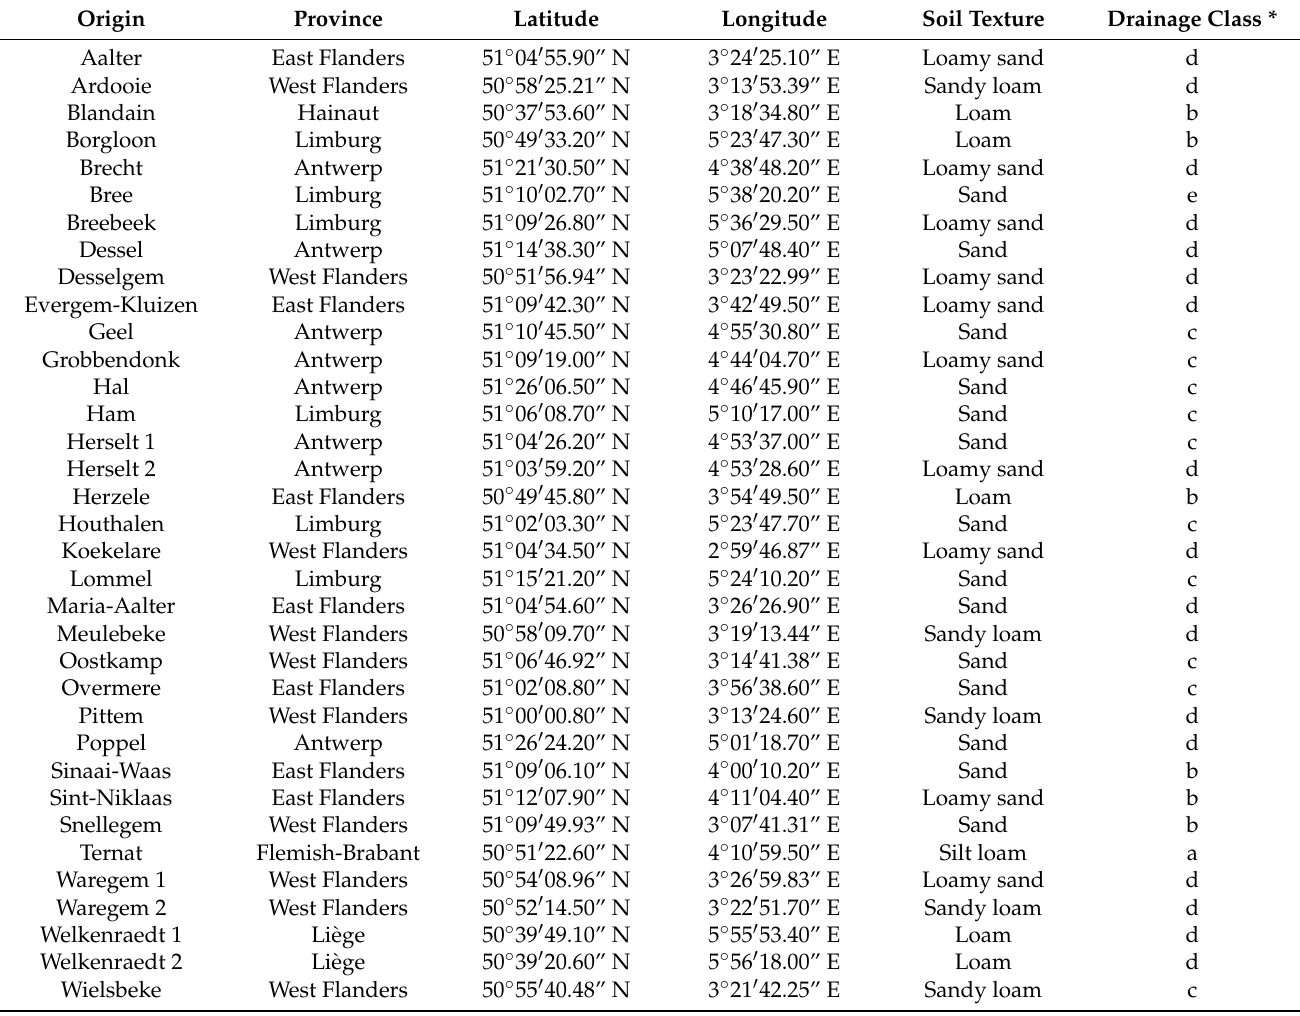
Table 1. Sampling locations (township and province) of 35 Belgian C . esculentus clonal populations with geographic coordinates, soil texture, and drainage class, derived from the digital soil map of Belgium